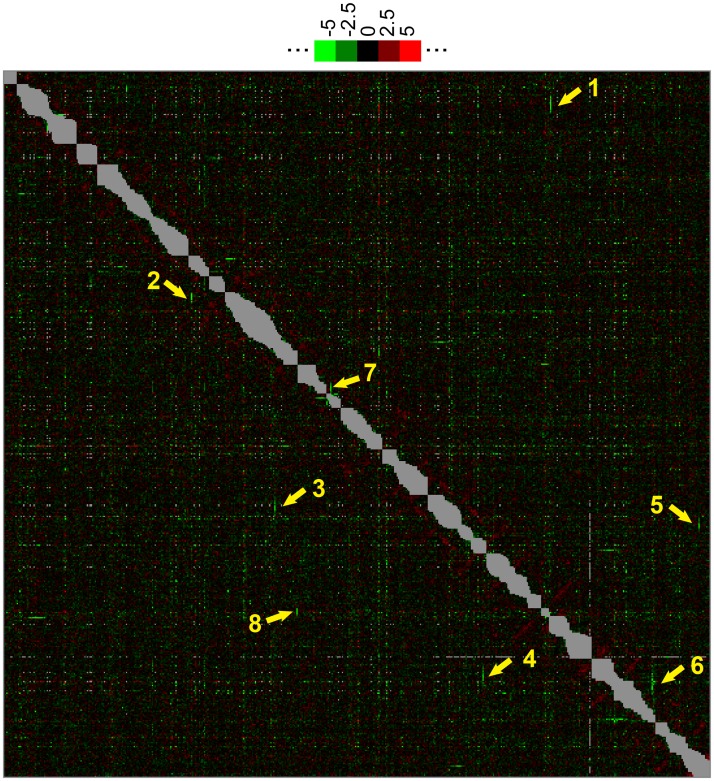
Interaction score heat map with genes ordered according to their chromosomal location.Standard names were replaced by the systematic names in the MSP-E-MAP interaction matrix (S3A Table) and the genes then ordered proceeding from Chr. I to XVI and on each chromosome from the end of the left arm towards the end of the right arm. This rearranged S score matrix (S3C Table) was transformed into the heat map shown here. Arrows point to some short green lines corresponding to a strong negative interaction of a single gene with all MSP set genes in a certain chromosomal region as follows: Arrow 2: CHO1 interacting with Chr. VII bp 63’048 to 202’273, encompassing EMC4 (= YGL231C), OST5, VRG4, YIP4, TPN1, YIP5 and AIM14 (= YGL160W). Arrow 3, PCP1 interacting with Chr. XII bp 41’280 to 211’933 encompassing YBT1 (= YLL048C), GPI13, RRT7, POM33, THI73, IZH3 and SMF3 (= YLR034C). Arrow 4, TDA5 interacting with Chr. XV bp 114’138 to 242’747 encompassing WSC3 (= YOL105C), IZH4, YPQ1, PHM7, YOL079W, DSC2, RRT8 and LDS2 (= YOL047C). Arrow 5, CTR1 (YPR124W) interacting with Chr. XII bp 323’544 to 444’688 encompassing SUL2 (= YLR092W), ZRT2, NHA1 and YLR152C. Arrow 6, COT1 (YOR316C) at the extreme end of Chr. XV interacting with the centromeric region of the same chromosome (bp 240’204 to 423’732) encompassing RRT8 (= YOL048C), LDS2, ALG6, DFG16, AKR2, IRC23 and RSB1 (= YOR049C). Arrow 7, pointing the vertical green line shows QDR2 interacting with Chr. VIII bp 256’360 to 467’914 encompassing YHR078W, HXT5, YHR140W, CHS7, PEX28, LAM1 and SVP26 (= YHR181W). Finally arrow 8, shows COS6 interacting with Chr. XIV bp 8’330 to 34’696 encompassing COS1 (= YNL336W), PFA3, LEM3, KRE1 and VNX1 (= YNL321W). This however is a false hit as we found out that cos6::kanMX in our library is in fact cos1::KanMX; the confusion arises because the two genes have very similar coding and flanking sequences. 16 well-delimitated grey zones along the diagonal correspond to the negative genetic interactions within each of the 16 chromosomes that were disregarded because of the close linkage of the interacting genes; the size of each zone is proportional to the number of MSPs on that chromosome, not the chromosome.